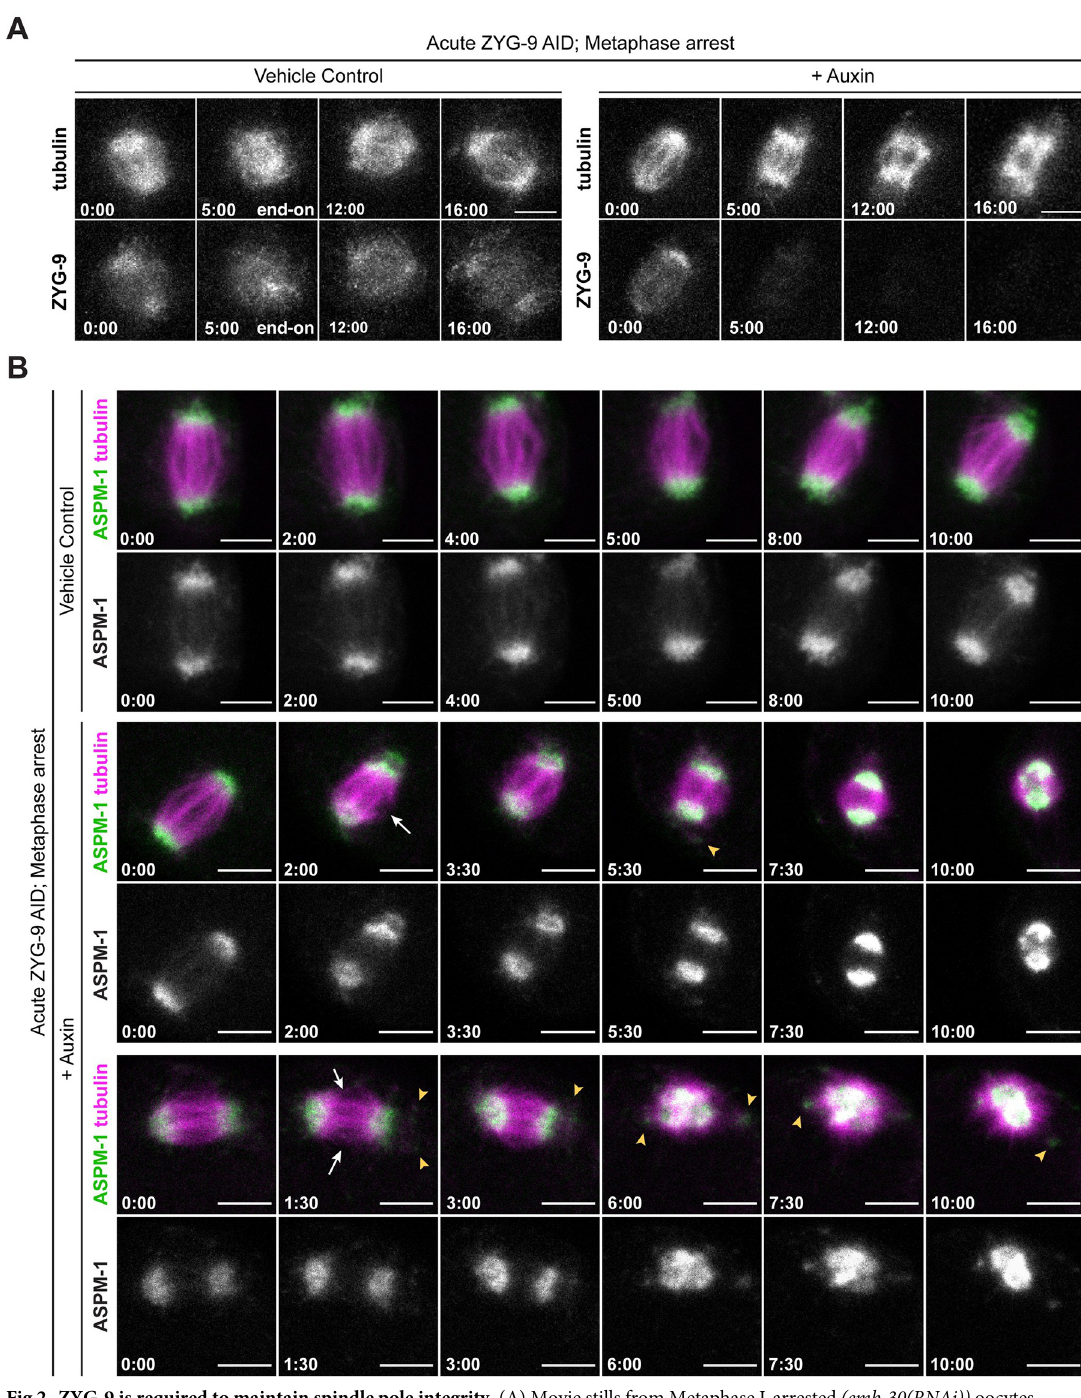
Fig 2. ZYG-9 is required to maintain spindle pole integrity. (A) Movie stills from Metaphase I-arrested (emb-30(RNAi)) oocytes expressing mCherry::tubulin and degron::GFP::ZYG-9 acutely treated with either vehicle (left) or 100 μ M auxin (right). Following vehicle treatment, the oocyte spindle maintains ZYG-9 on the spindle and remains bipolar throughout the timecourse (n = 4). Auxin treatment causes a rapid loss of ZYG-9 signal and a concurrent loss of spindle pole stability highlighted by the unfocusing and fragmentation of the spindle poles (n = 4). Bars = 5 μ m. Timestamp = min:sec. (B) Movie stills from Metaphase I-arrested (emb-30(RNAi)) oocytes expressing mCherry::tubulin, degron::GFP::ZYG-9, and GFP::ASPM-1 to track acentrosomal poles. Stable bipolar spindles have clear, focused ASPM-1 foci on either side of the spindle in control oocytes (n = 4). Acute 100 μ M auxin treatment to deplete ZYG-9 causes a rapid unfocusing and fragmentation of ASPM-1 foci, confirming loss of spindle bipolarity (n = 5). Splayed microtubule bundles can be seen